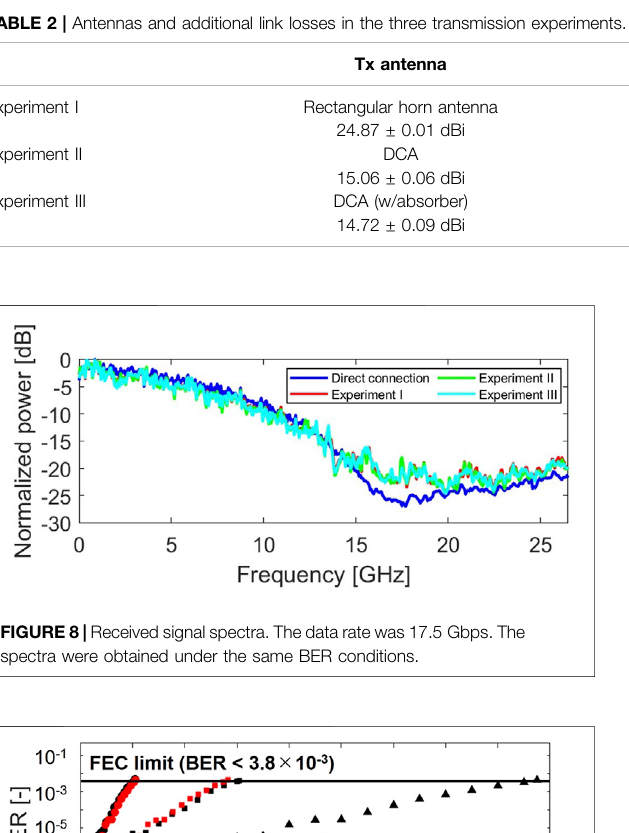
Frontiers in Communications and Networks |